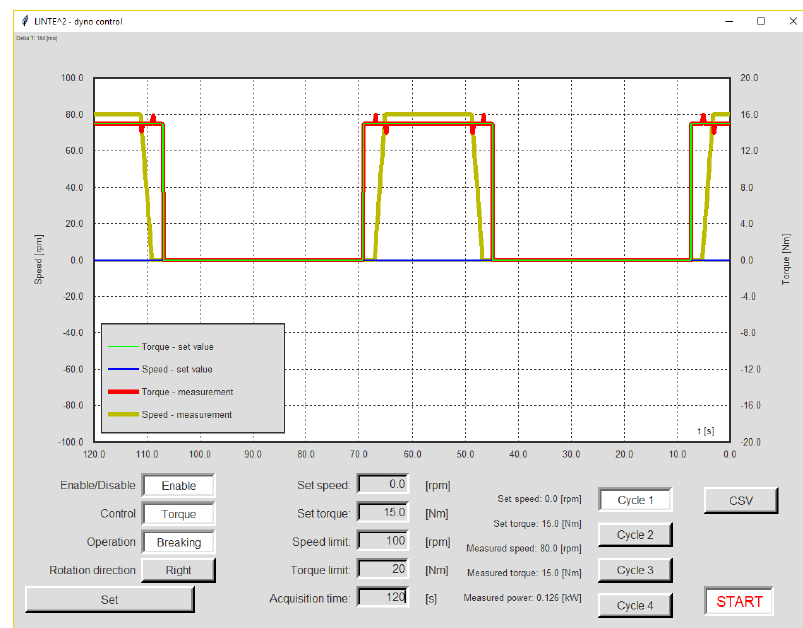
Figure 12. A graphical interface for the control software used to emulate crane load characteristics. Energies 2020 , 13 , x FOR PEER REVIEW